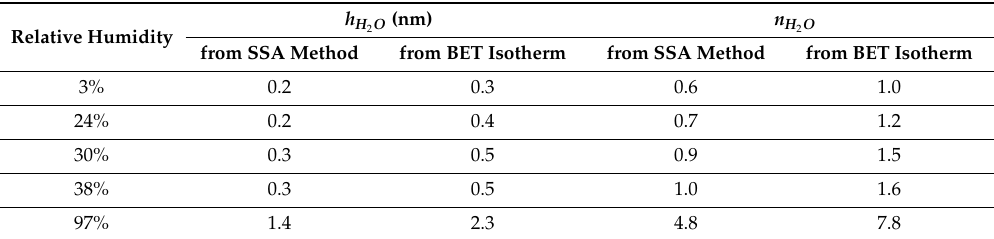
Table 5. Water layer thickness and number of monolayers of H 2 O molecules adsorbed on the surface of GoHAP-6 (40 nm), depending on the experimental conditions and an exposure time of 20 h.